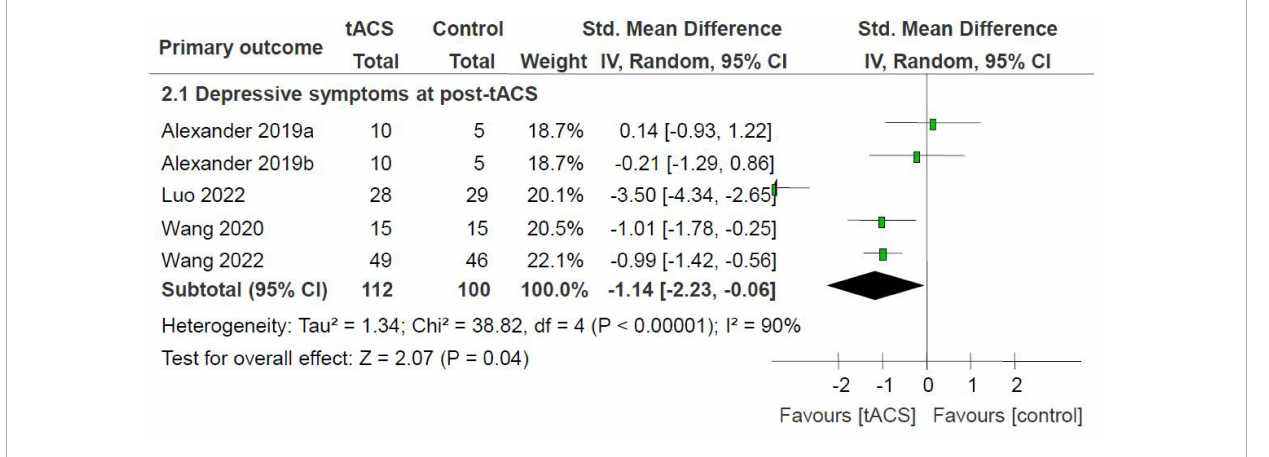
FIGURE2 tACS for MDD: depressive symptoms at post-tACS as measured by the HAMD. HAMD, Hamilton Depression Rating scale; MDD, major depressive disorder; tACS, transcranial alternating current stimulation.